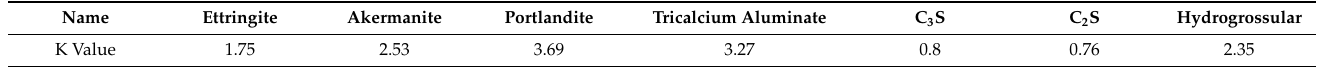
Table 3. K values of the hydration products at different ambient RHs.